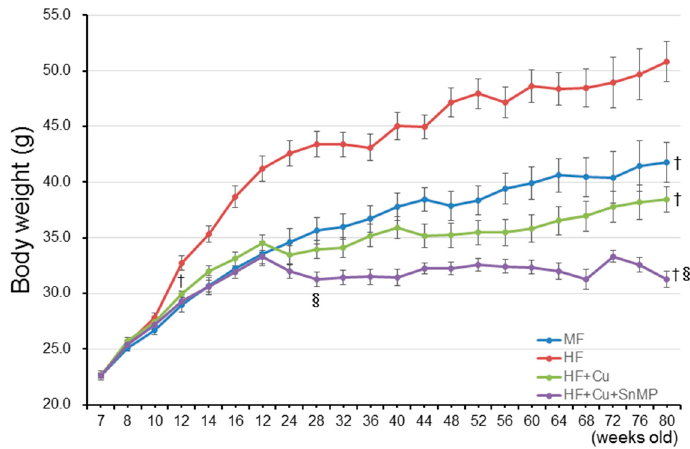
Figure 1. Mice were fed with standard feed (MF), high-fat diet (HFD), 0.1% curcumin-mixed HFD (HFD + Cu), or 0.1% curcumin-mixed HFD with administration of SnMP (HFD + Cu + SnMP) for 72 weeks from 8 weeks old to 80 weeks old. Data are presented in mean ± standard error for each group ( n = 20). † P < 0.05. vs. HFD, § P < 0.05 vs. HFD + Cu. SnMP, Stannous Mesoporphyrin.